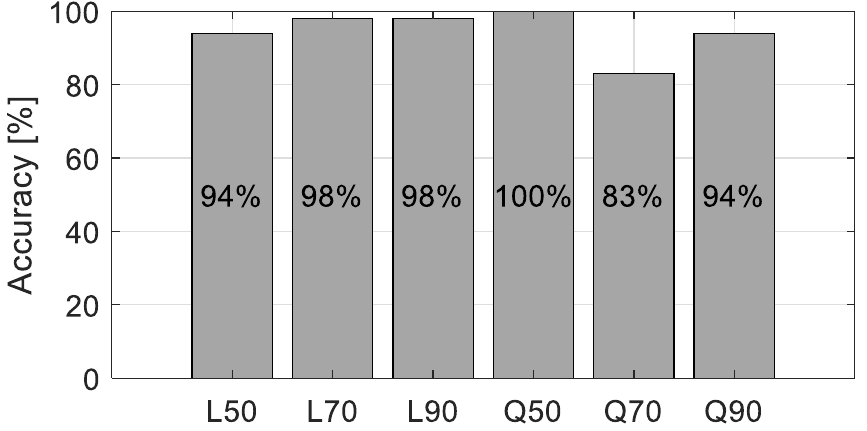
Figure 8. The success rate for identifying foundation property.